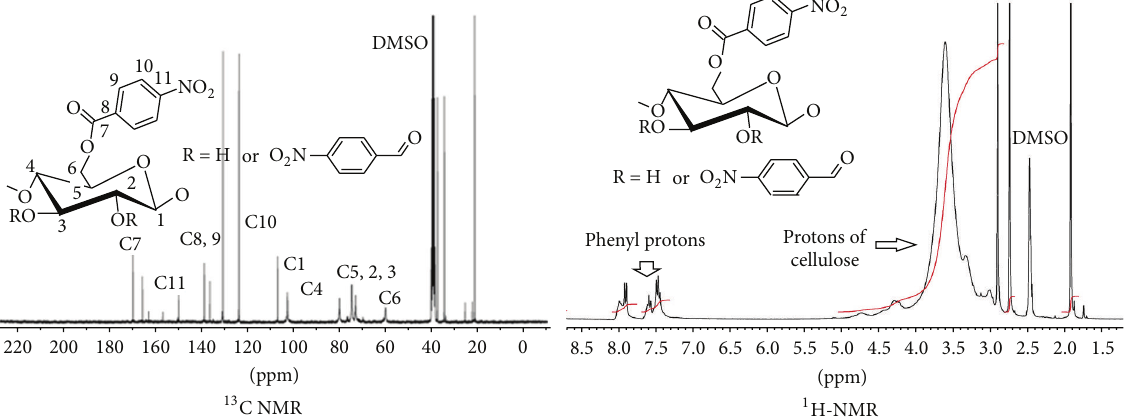
Figure 2: NMR spectra of kraft cellulose p -nitrobenzoate.